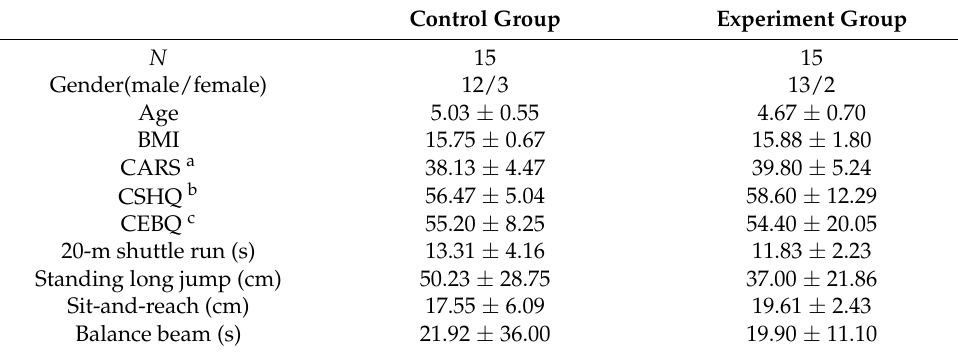
Table 2. Participant demographics evaluation results (M ± SD).